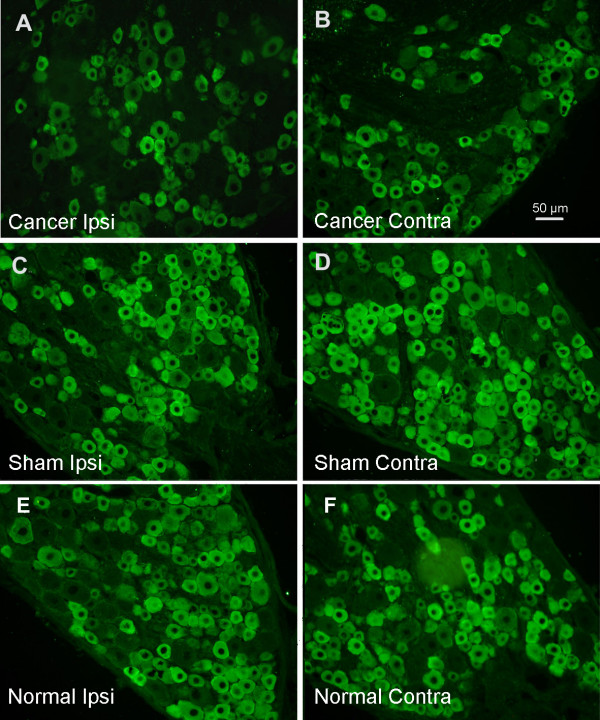
Representative images of Nav1.8 immunofluorescence in bilateral DRG from rats of the Walker 256 group, the sham group and the normal group. (A) Ipsilateral and (B) contralateral DRG from a tumor-bearing rat. (C) Ipsilateral and (D) contralateral DRG from a sham rat. (E) Ipsilateral and (F) contralateral DRG from a normal rat. Note that Nav1.8 expression in tumor-bearing rats decreased compared to the normal group, although it is not clear from a simple vision inspection whether expression was lower on the ipsilateral or the contralateral side, highlighting the need for quantitative analysis. Scale bar, 50 μm.